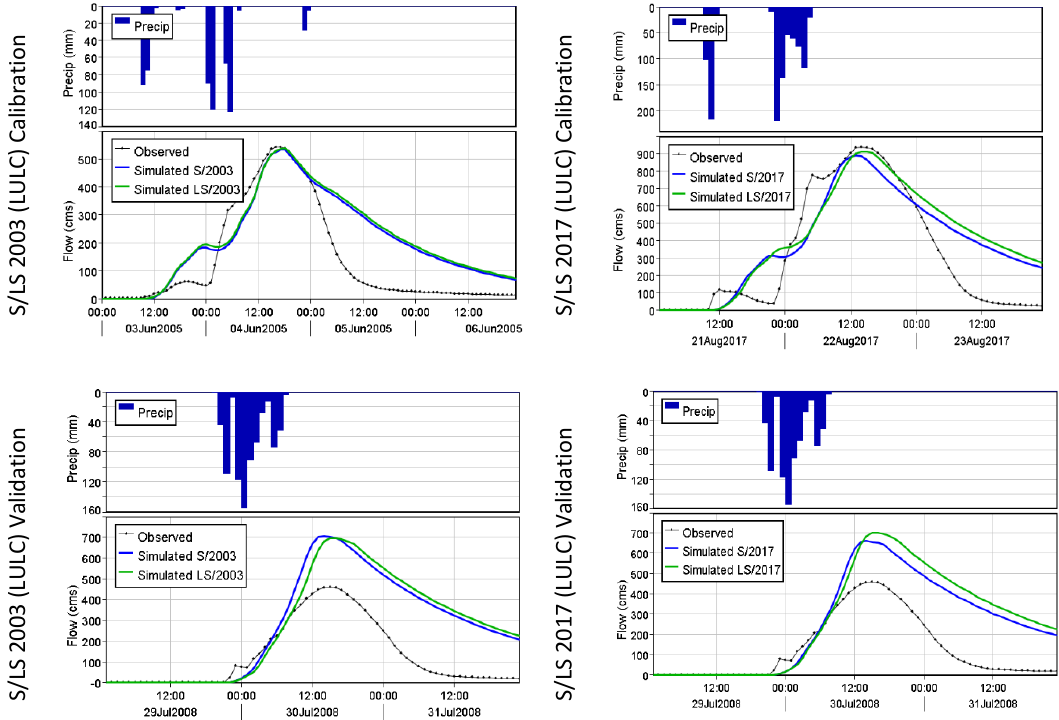
Figure 11. Calibrated and validated hydrographs at the Blue River watershed outlet for SPOT (S) and LANDSAT (LS) LULC conditions.